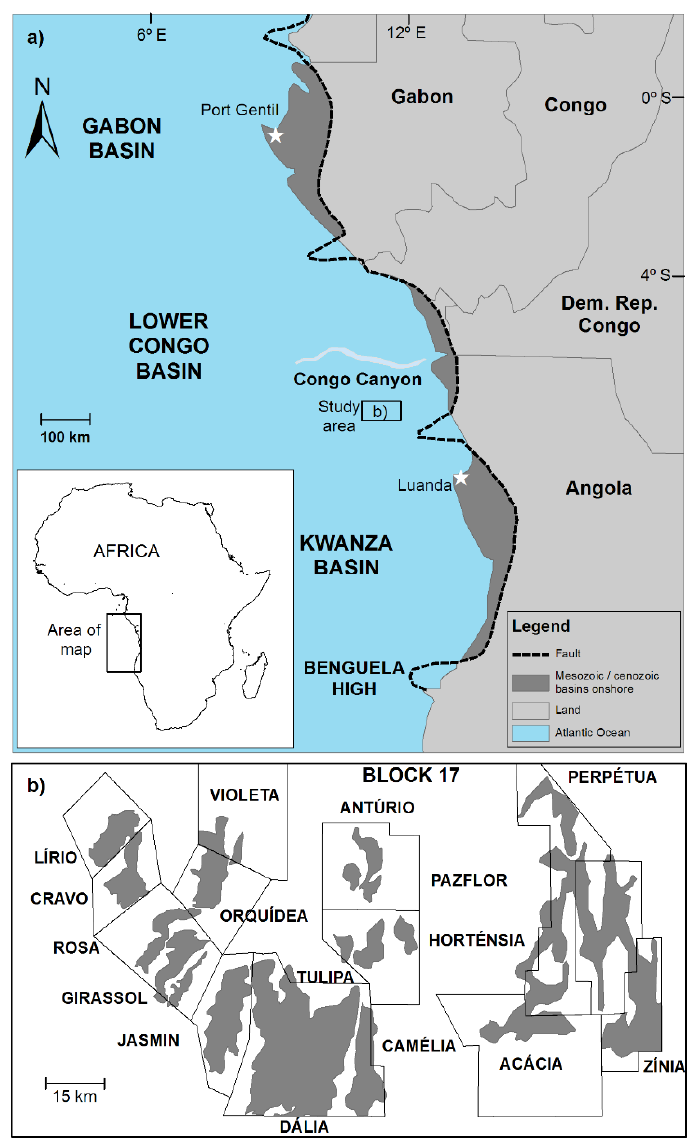
Figure 1. ( a) Map showing the location of the study area in Africa; and (b) zoom revealing the location Figure 1. ( a ) Map showing the location of the study area in Africa; and ( b ) zoom revealing the location of the fields. of the